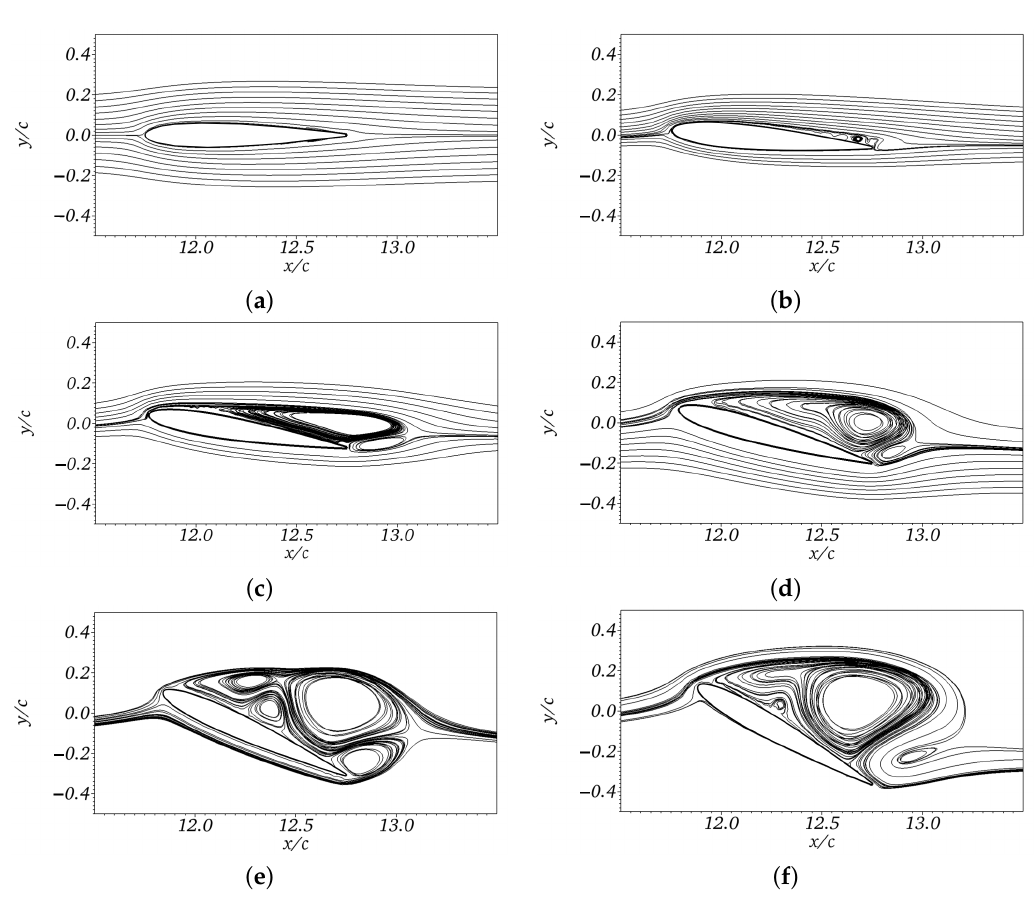
Figure 13. Streamlines of mean velocity fields: ( a ) α = 0 ◦ , ( b ) α = 5 ◦ , ( c ) α = 10 ◦ , ( d ) α = 16 ◦ , ( e ) α = 25 ◦ and ( f ) α = 30 ◦